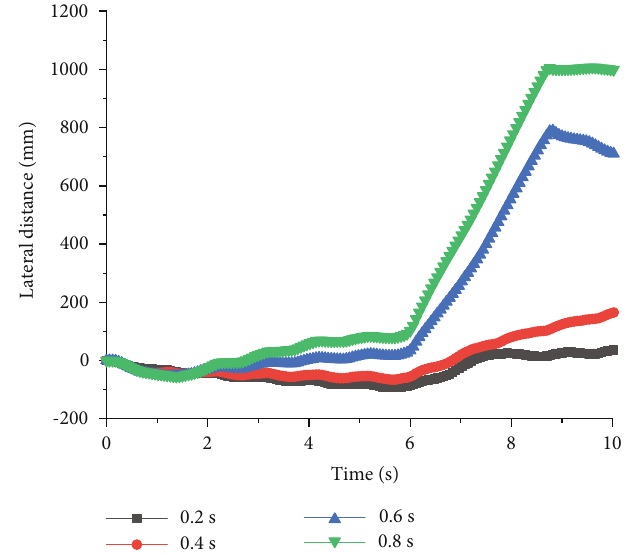
Figure 9: Lateral distances of quadruped robots with full elbow joint with di ff erent period at a constant speed.